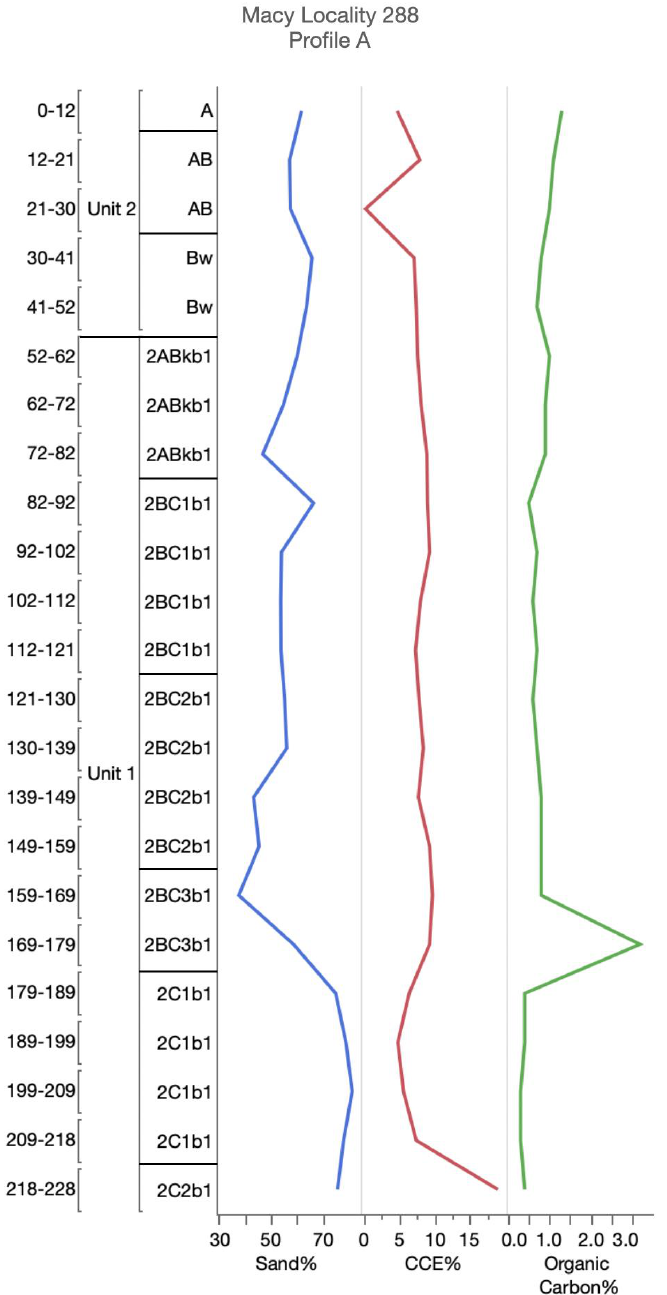
Figure A14. Accepted radiocarbon ages and soil and sediment analysis at Macy Locality 288, Profile A—Post research area, northwest, Texas. CCE = calcium carbonate equivalence.